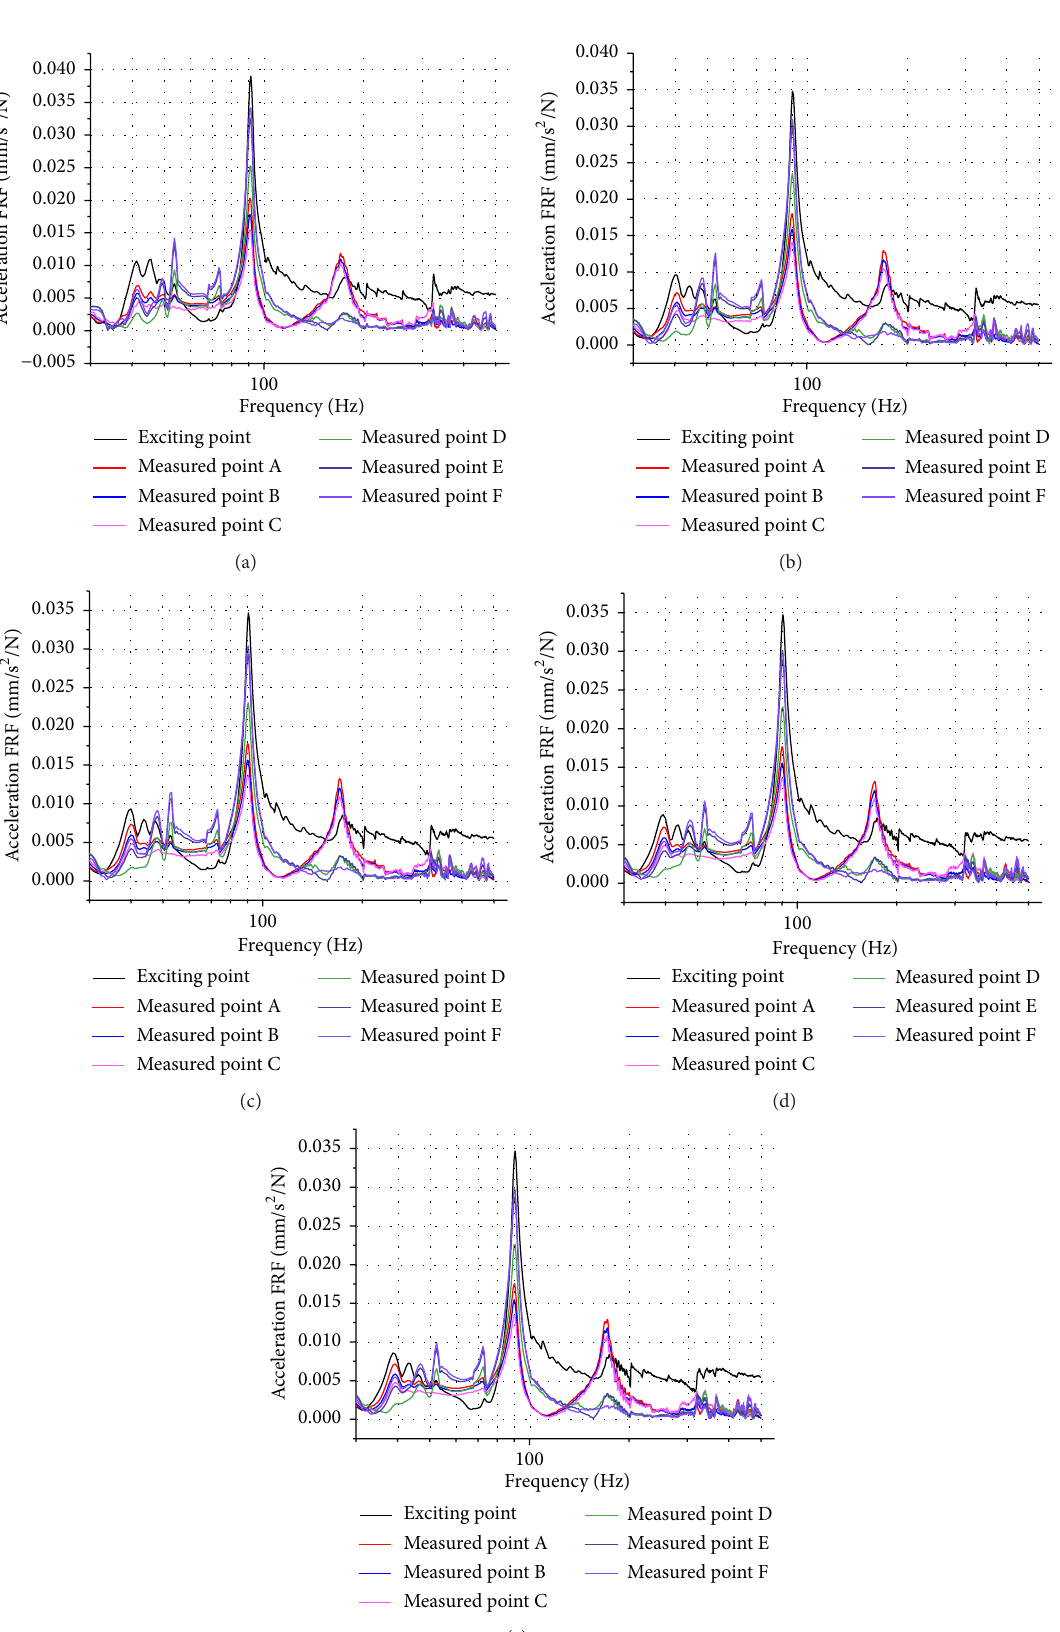
Figure 28: Acceleration FRF of the verification base with different exciting forces: (a) 10 N, (b) 20 N, (c) 30 N, (d) 40 N, and (e) 50